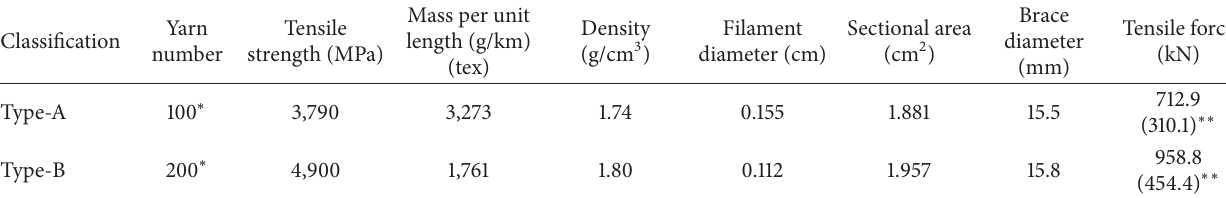
Table 1: The physical properties of the carbon fibers used in this study.